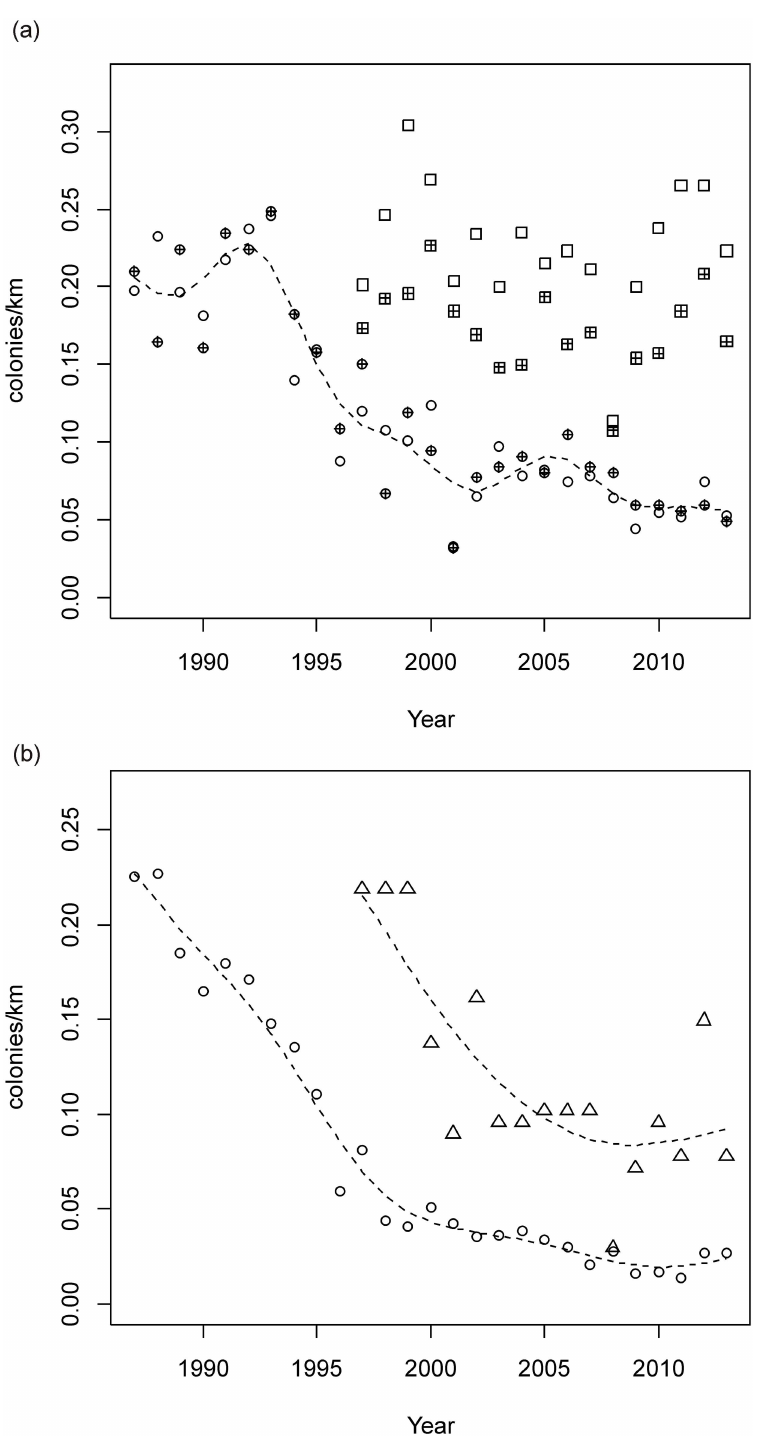
Fig 2. Beavercolony numbers/km by year for (a) trout streamswithout targeted beaver management and (b) trout streamswith targeted beaver management for the Chequamegon-Nicolet National Forest. In panel (a), open circle = Nicolet trout streams, filled circle = Nicolet non-trout streams, open square= Chequamegon trout streams, filled square = Chequamegon non-trout streams. In panel (b), open circle = Nicolet side, triangle= Chequamegon side. Dotted lines are the predictedtrends from generalized additivemodels (significanttrends